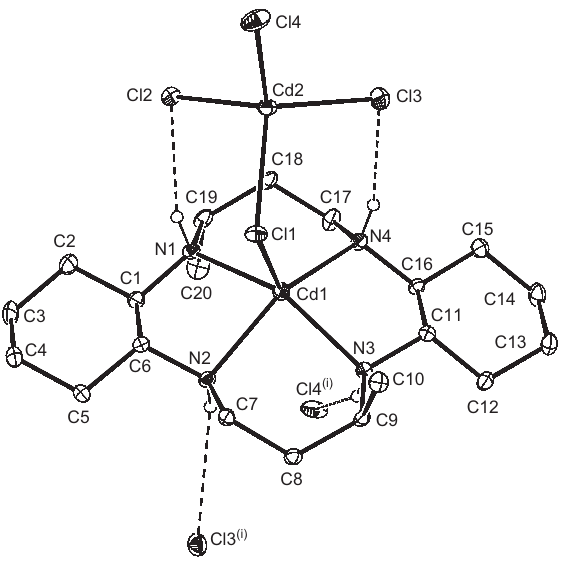
Figure 1 An ORTEP drawing (30 % probability ellipsoids) of ] ( 1 ) with the atomic numbering scheme. [Cd II (L)( µ -Cl)Cd II Cl 3 The hydrogen bonds are shown as dashed lines.